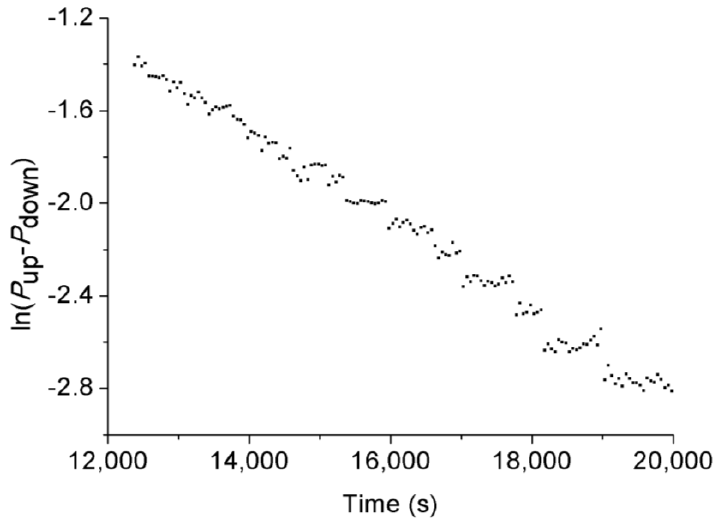
Figure 21. Logarithmic decay of difference between upstream pressure and downstream pressure at 20 MPa confinement.